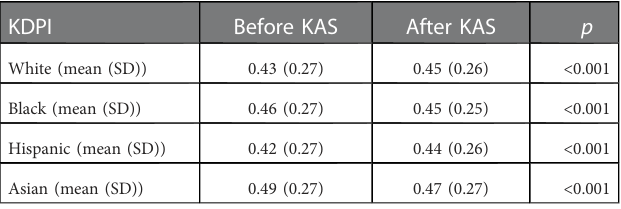
TABLE 3 KDPI of kidneys allocated to patients of different races/ethnicities before and after KAS implementation.